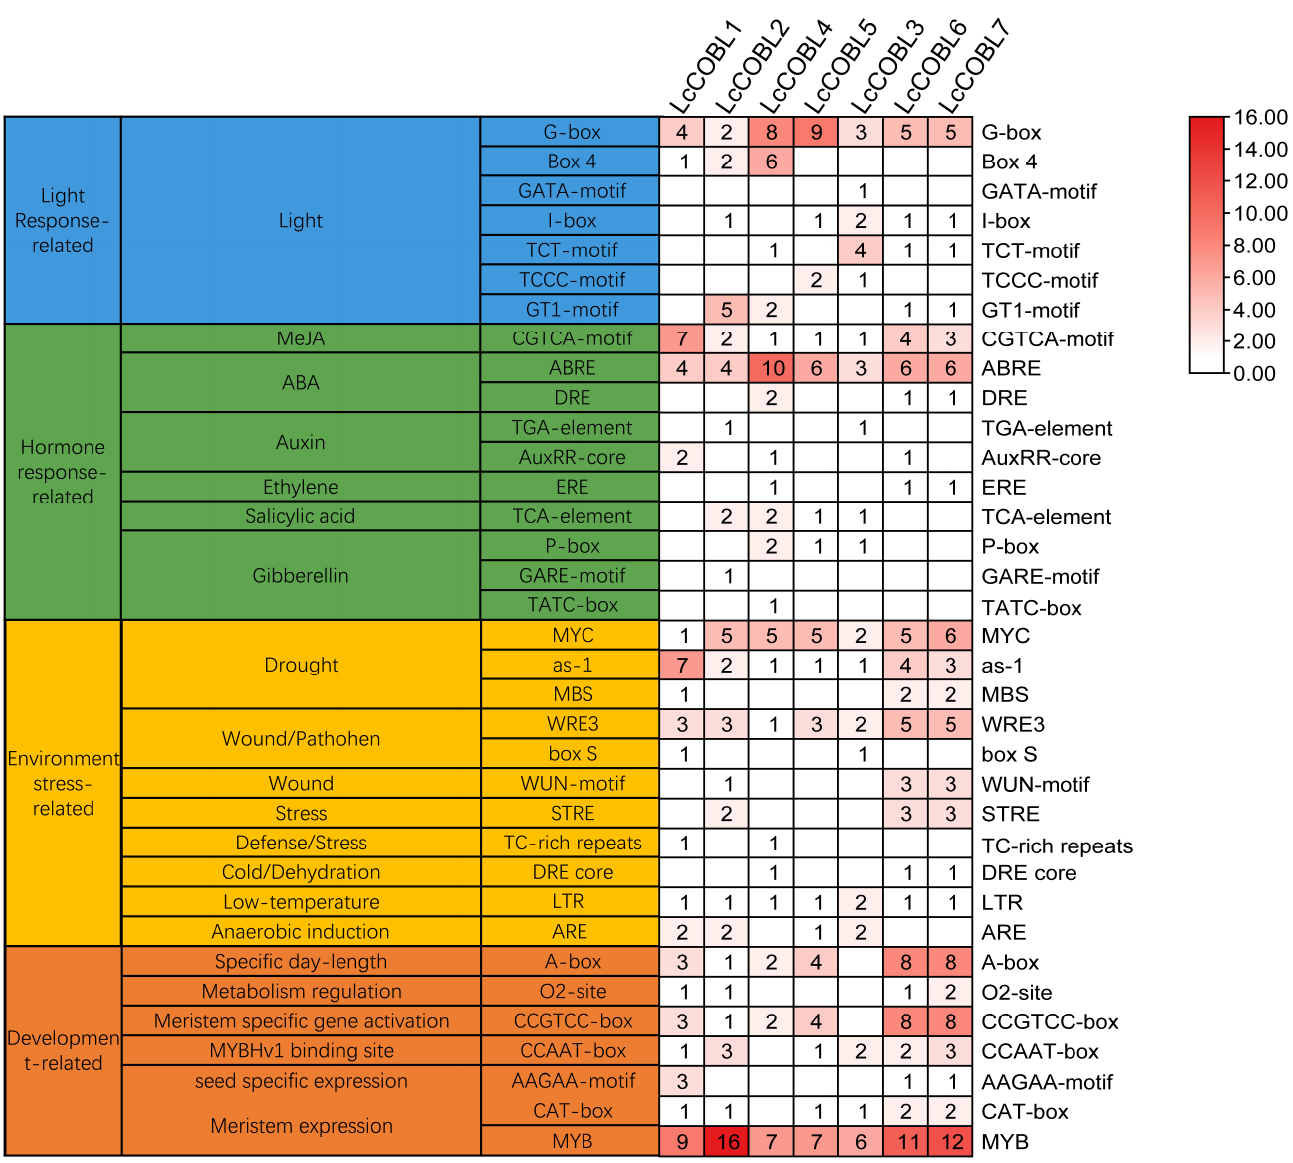
Figure 4. Analysis of cis-elements on LcCOBL promoters. Cis-elements in the upstream 2000 bp area of LcCOBL promoters. Different colors in the table indicate different types of promoters, and numbers indicate the numbers of different promoter elements.